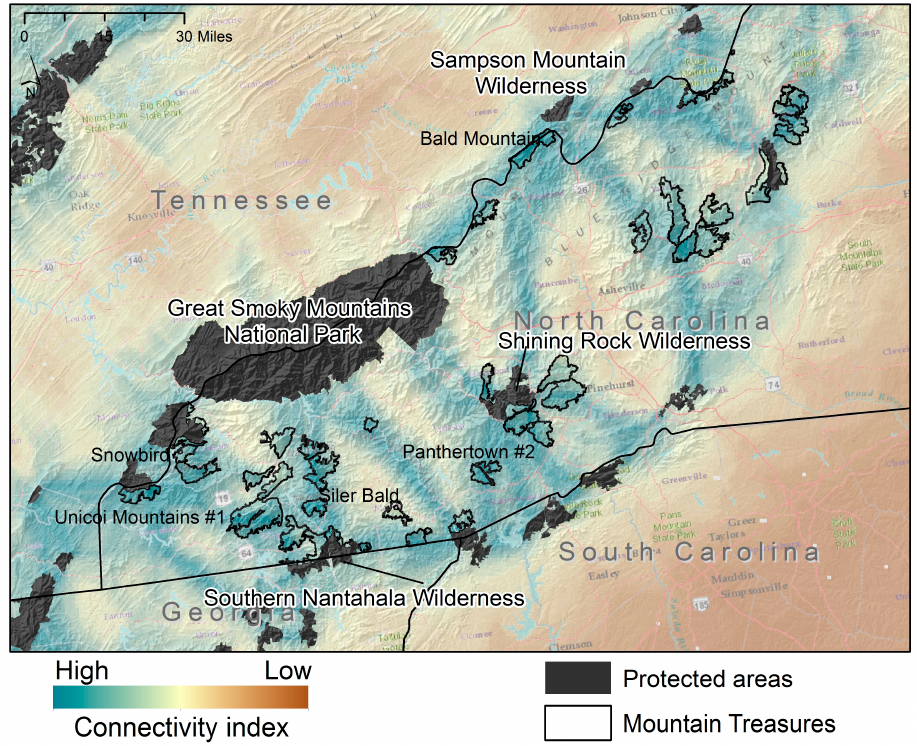
Figure 4. Map of the connectivity priority value between protected areas for the Southern Appalachian Mountains, highlighting the Mountain Treasures based on data from Belote et al. (2016). Many of the Mountain Treasures lie between existing protected areas and therefore represent important priorities for maintaining connections between existing conservation reserves including the Great Smoky Mountains National Park and wilderness areas on the Nantahala and Pisgah National